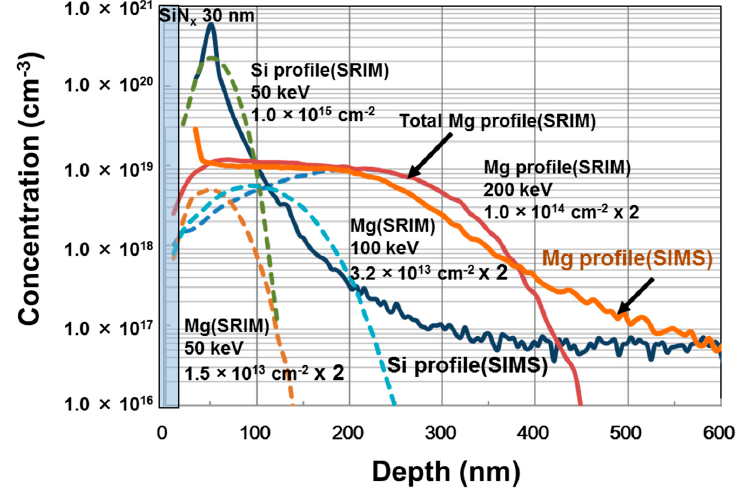
Figure 6. Ion-implanted Mg and Si profiles in a free-standing GaN substrate. Si background concentration in the substrate was about 5 × 10 16 cm − 3 .